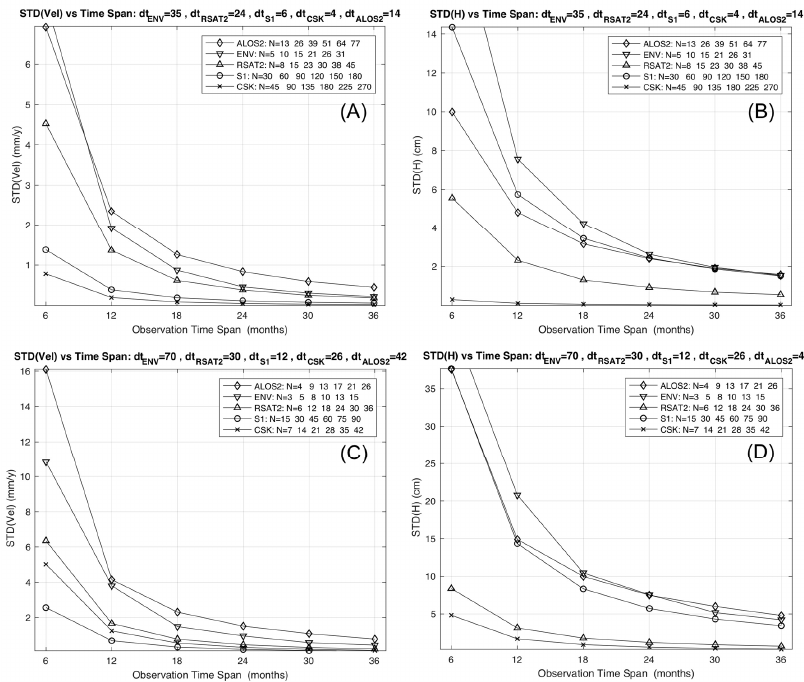
Figure 1. Mean velocity standard deviation ( A , C ) and lower limit of the height standard deviation ( B , D ) corresponding to different observation time spans, and computed for ALOS2, ENV, RSAT2, CSK and S1 missions, according to revisit time values reported in the respective plot titles.